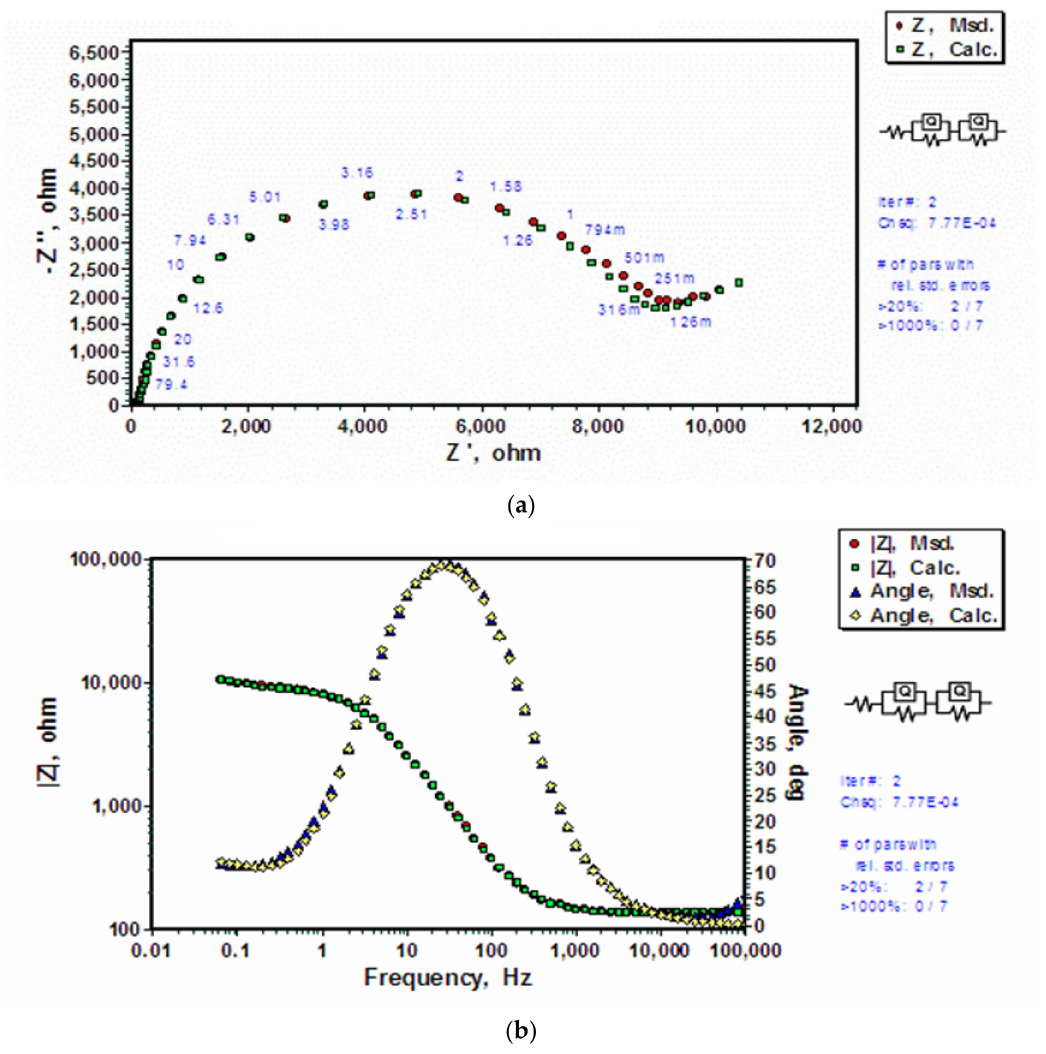
Figure 4. Experimentally measured and calculated data using the electrical equivalent circuit, R s (Q o R o )(Q dl R dl ), for uncoated AZ91D alloy exposed to 0.1 M NaCl solution: ( a ) Nyquist plots for impedance data, and ( b ) Bode and phase angle plots (|Z| stands for impedance). Table 1. Corrosion of uncoated AZ91D: Calculated parameters for components in